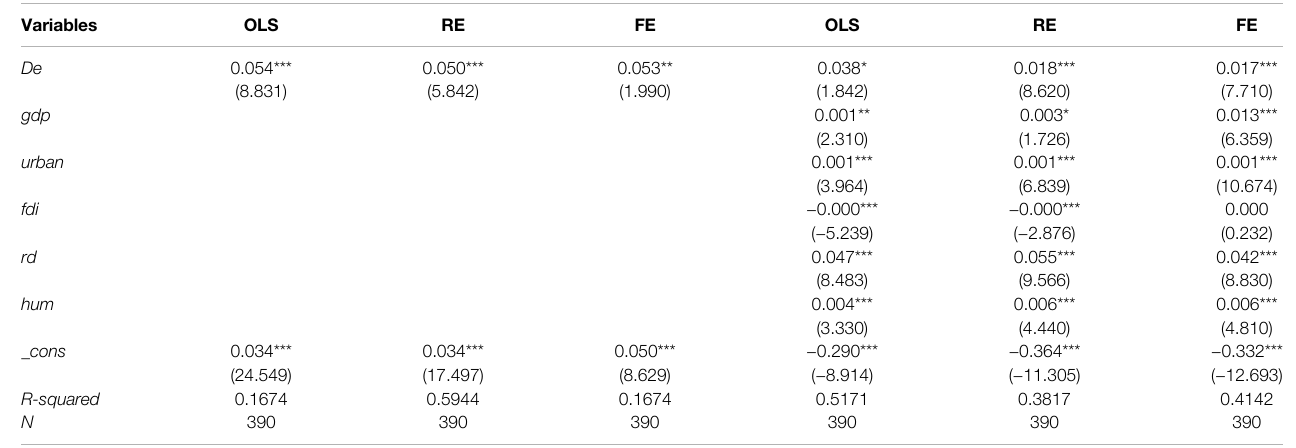
TABLE 3 | Baseline regression